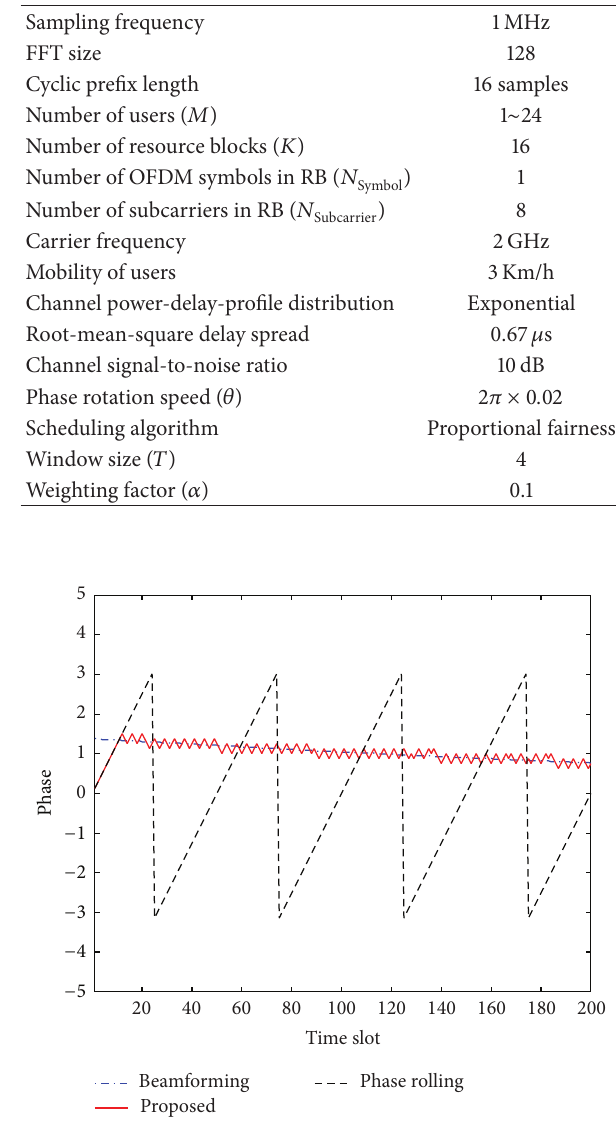
Figure 4: Phase of the second